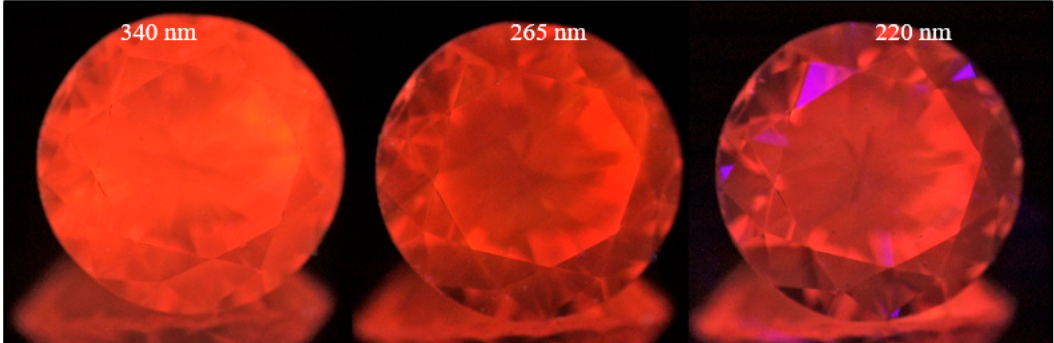
Figure 22. A pure type Ib brown diamond (sample TH 2.51) under three different UV excitations of the DFI system. The NV 0 center is responsible for the luminescence under all excitations, and the distribution of the defects is much less obvious than in other deformation-related samples. Photos: Dr. Thomas Hainschwang.